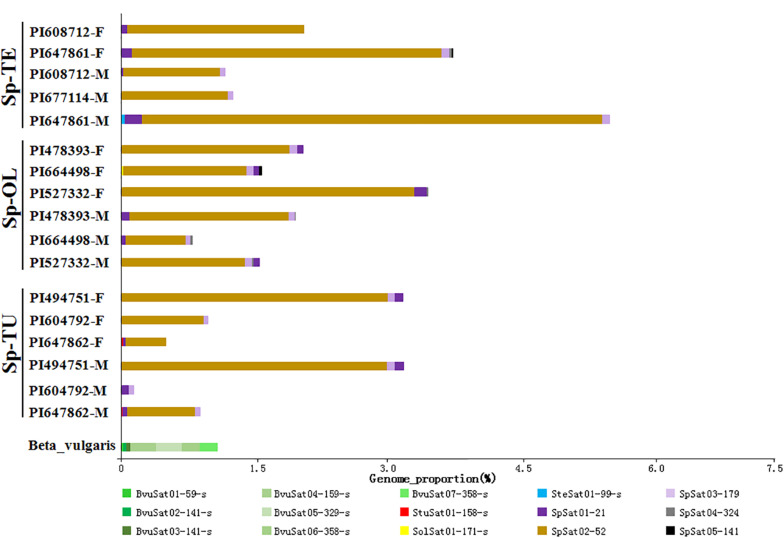
Estimated satellite abundance in spinach and sugar beet genome. The size of the rectangle is proportional to the number of reads in a cluster for each species. Colors of the rectangles correspond to repeat type. See Table 1 for species codes.